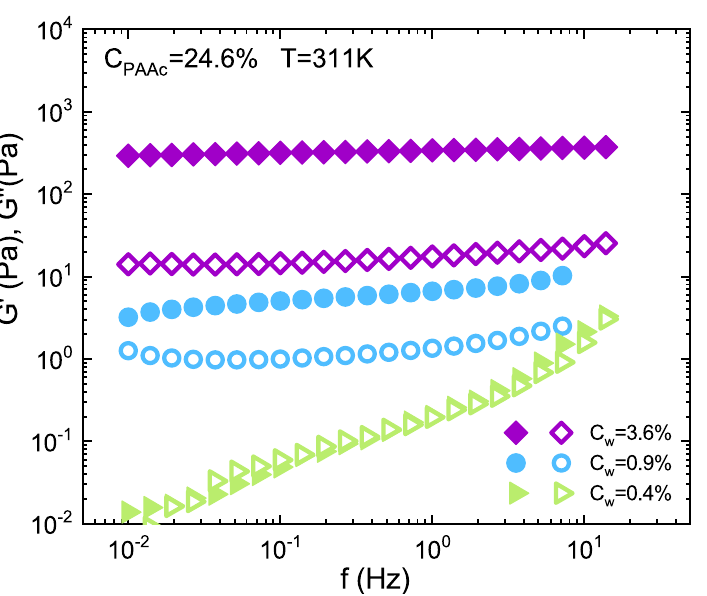
Figure 7. Storage G ’ (filled symbols) and Loss G ” (open symbols) moduli as a function of frequency for IPN microgels with C PAAc = 24.6% at concentration C w = 0.4% in the liquid, C w = 1.0% in the glass and C w = 3.6% in the jammed state and at T = 311K above the